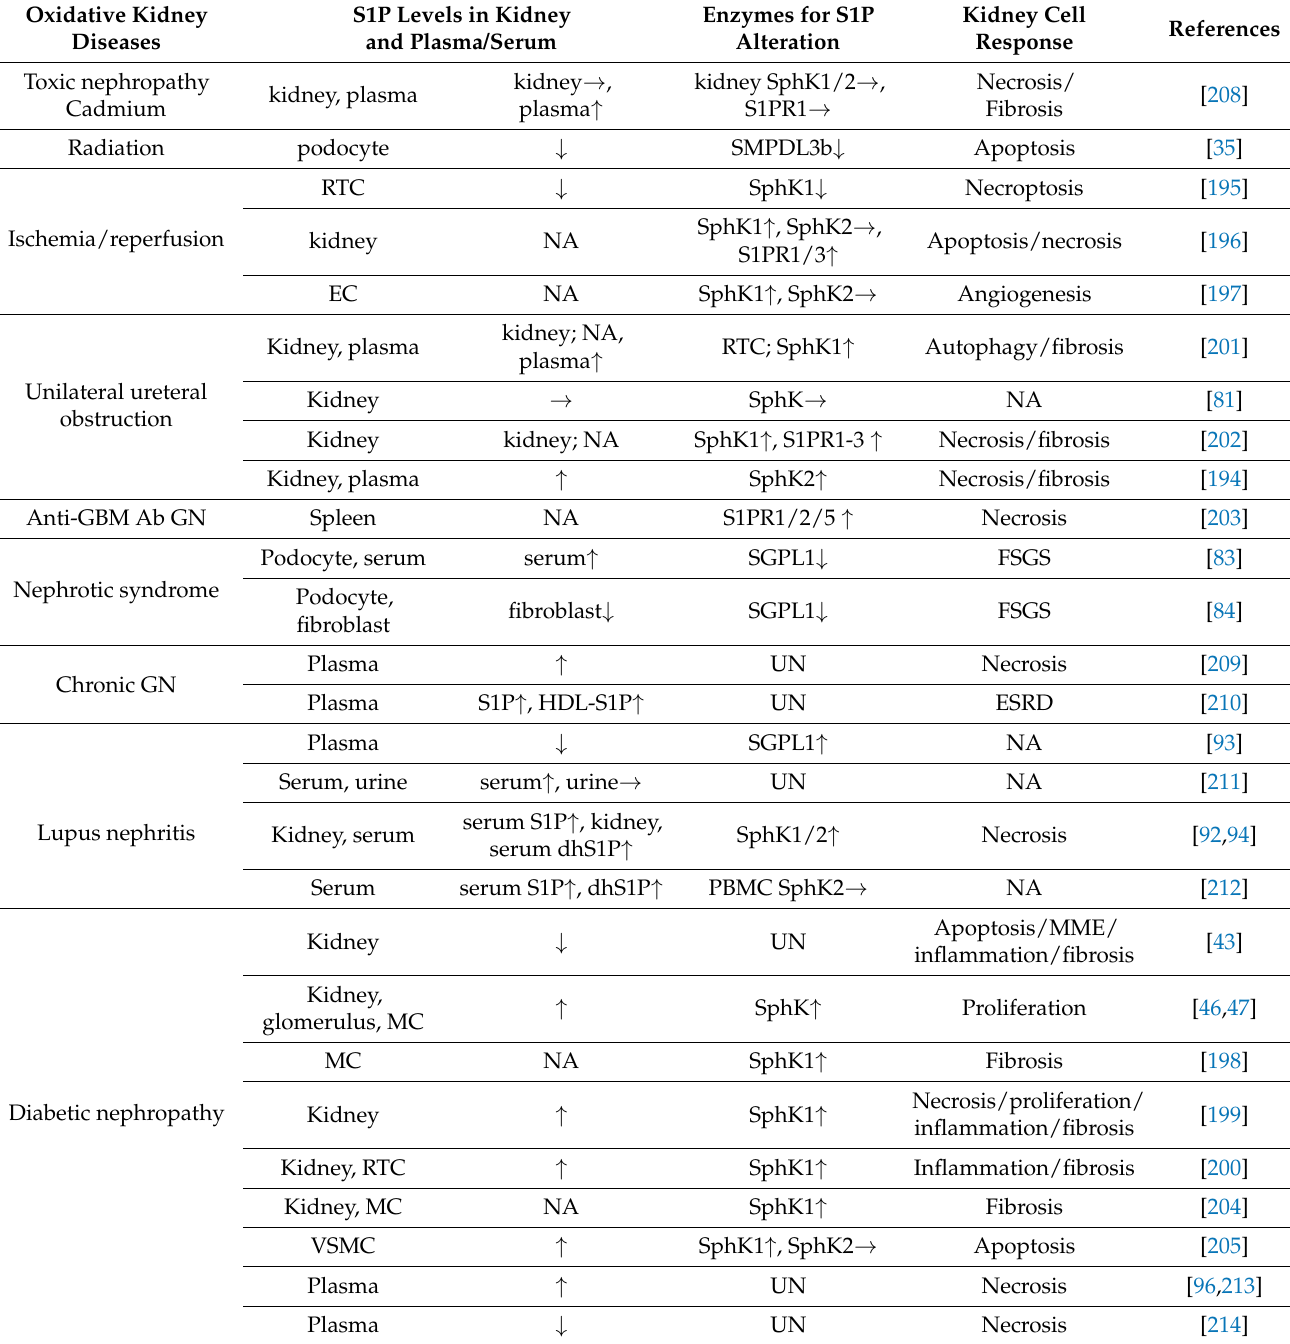
Table 3. Alteration of sphingosine-1-phosphate levels and kidney cell response in oxidant-induced kidney